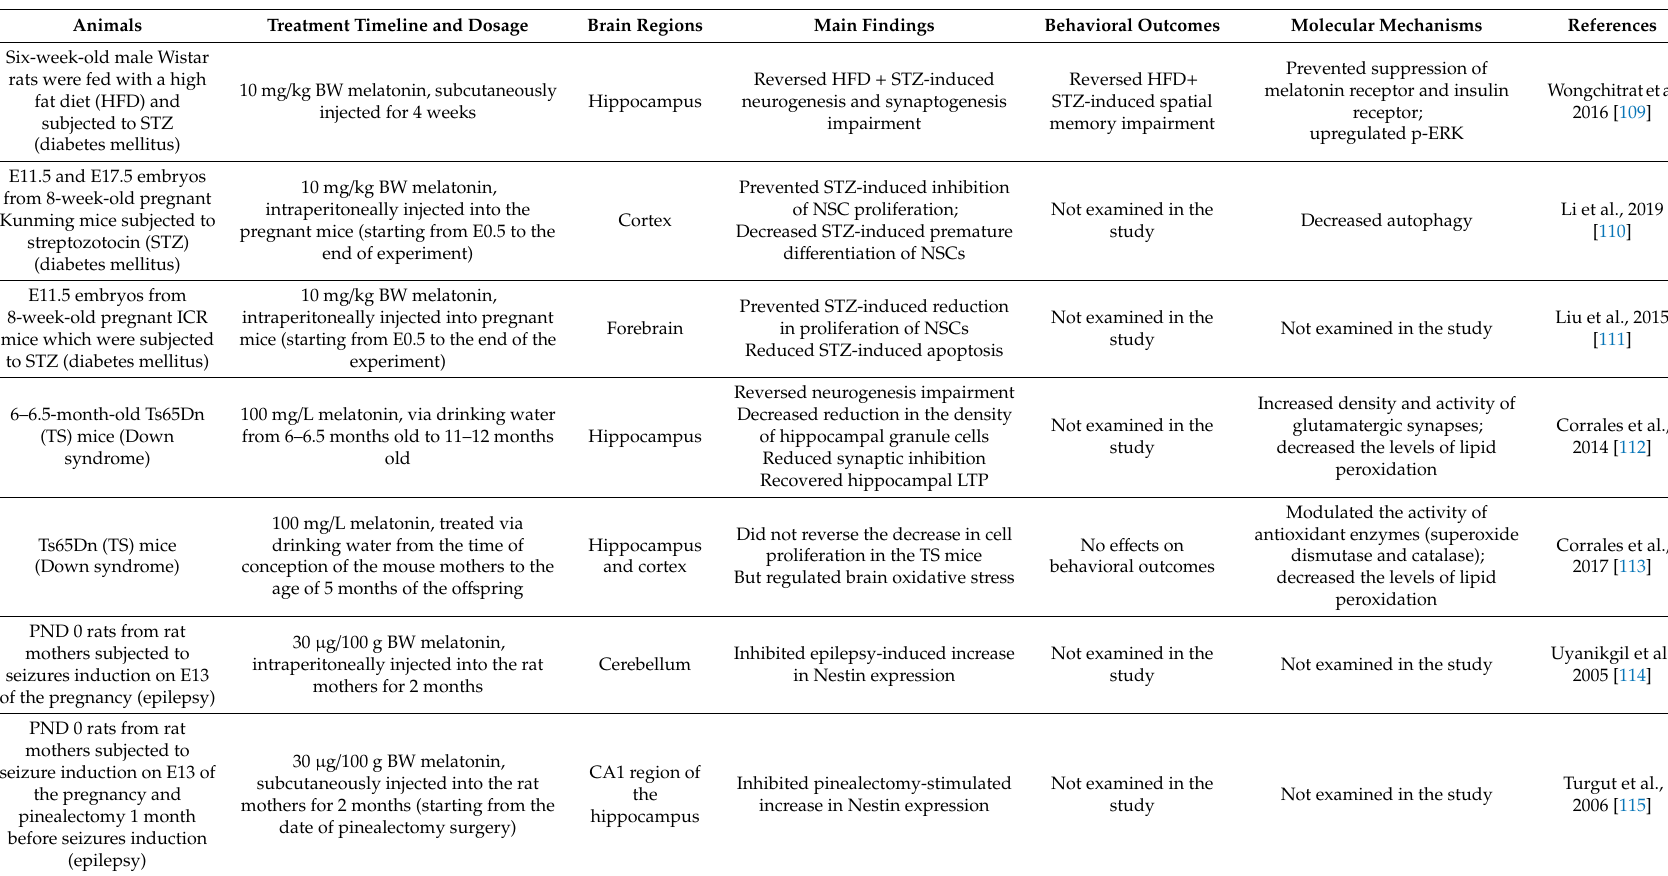
Table 12. The main findings regarding the e ff ects of melatonin on neurogenesis in other neurogenesis impairment-related diseases and the respective molecular mechanisms in the in vivo